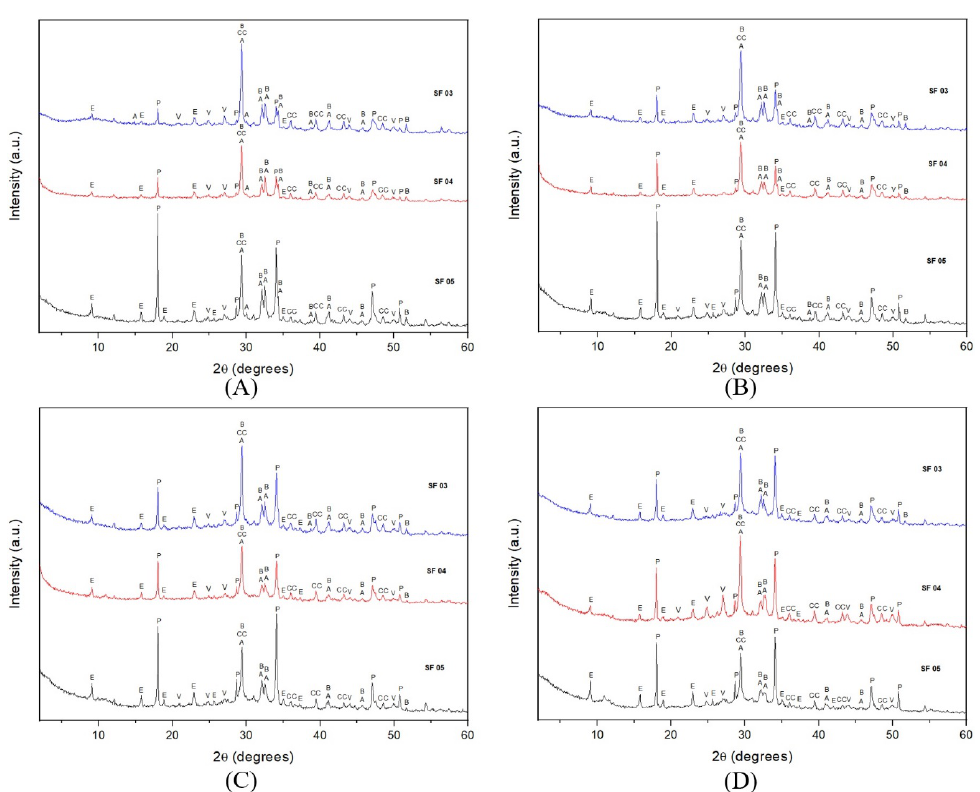
Figure 7. Diffractograms of the cementitious pastes with the replacement of Portland cement by 10% of silica fume, with 1 day (A), 3 days (B), 7 days (C), and 28 days (D) of hydration. E-ettringite, P-portlandite, V-vaterite, A-alite, CC-calcite,